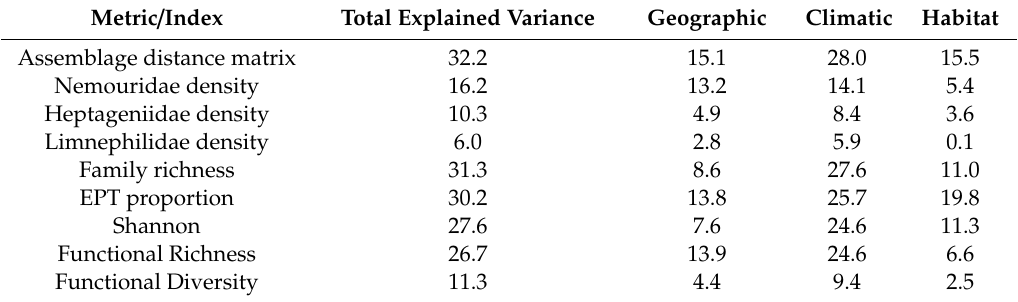
Table 2. Results of variance partitioning on macroinvertebrate metrics and indices. Values reported are the adjusted R 2